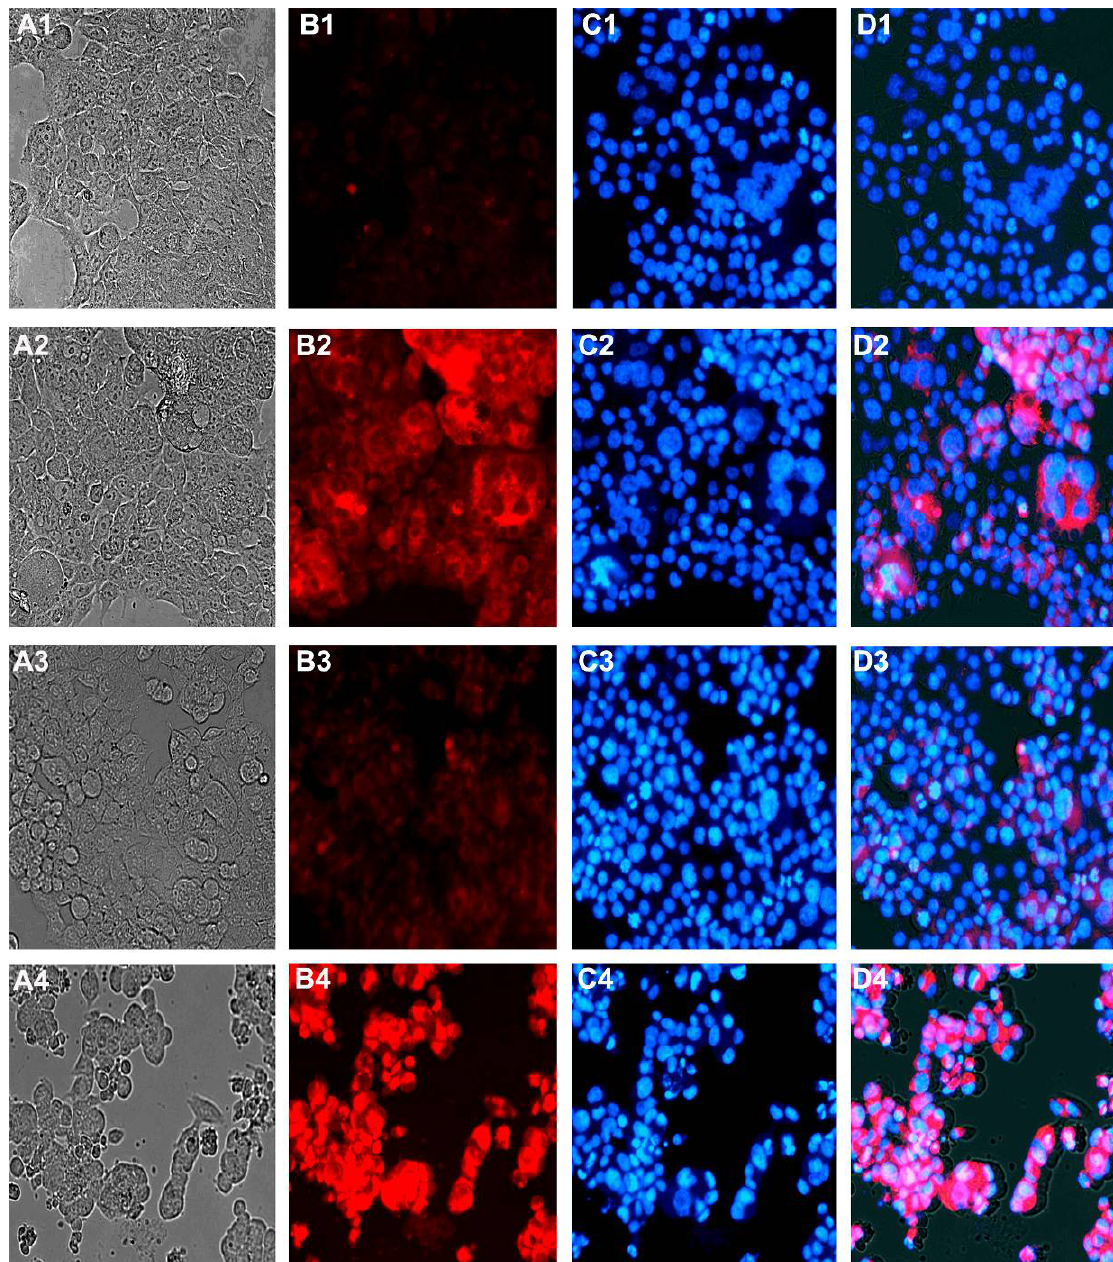
Figure 6. Effect of α -mangostin, betulinic acid (BA) and their combination on the morphology, mitochondrial membrane potential, and chromatin condensation of HCT 116 cells. Untreated cells ( A1–D1 ), treated with BA at 7.5 µg/mL ( A2–D2 ), treated with α -mangostin at 3.75 µg/mL ( A3–D3 ), and their combination ( A4–D4 ). The treatment time was 16 h, and ( 1 ) refers to light micrograph of unstained cells; ( 2 ) stained with rhodamine 123, ( 3 ) stained with Hoechst 33258, and ( 4 ) is an overlay of the 3